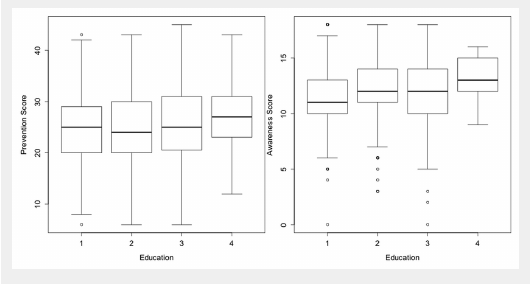
Box plots of the ultraviolet radiation prevention score and gender, age category, skin type and personal history of skin cancer of the participants, univariate level. The correlation between the UVR prevention score and gender, age category, skin type, and personal history of skin cancer were statistically significant (for individual p-values refer to table 2). Four age categories were made, based on the year of birth of the athletes: Category 1 (18–24 years), category 2 (25–34 years), category 3 (35–54 years) and category 4 (≥55 years). The skin type was divided into four different groups: category 1 (Fitzpatrick skin type I), category 2 (Fitzpatrick skin type II), category 3 (Fitzpatrick skin type III) and category 4 (Fitzpatrick skin type